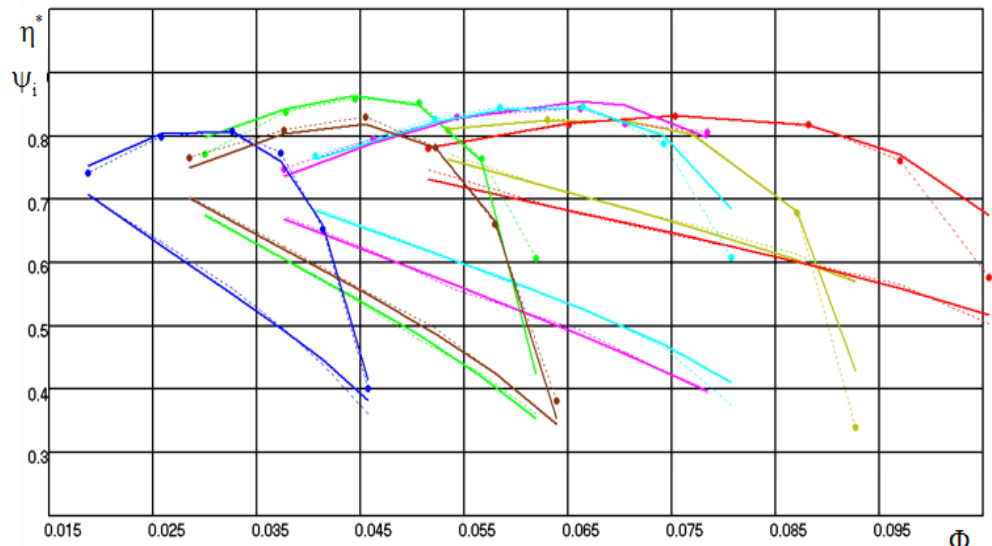
Figure 8. IDENT program. Characteristics of Compression Engineering Problem Laboratory SPbPU model stages [23] (dashed lines), and their calculated characteristics after identification (solid lines).